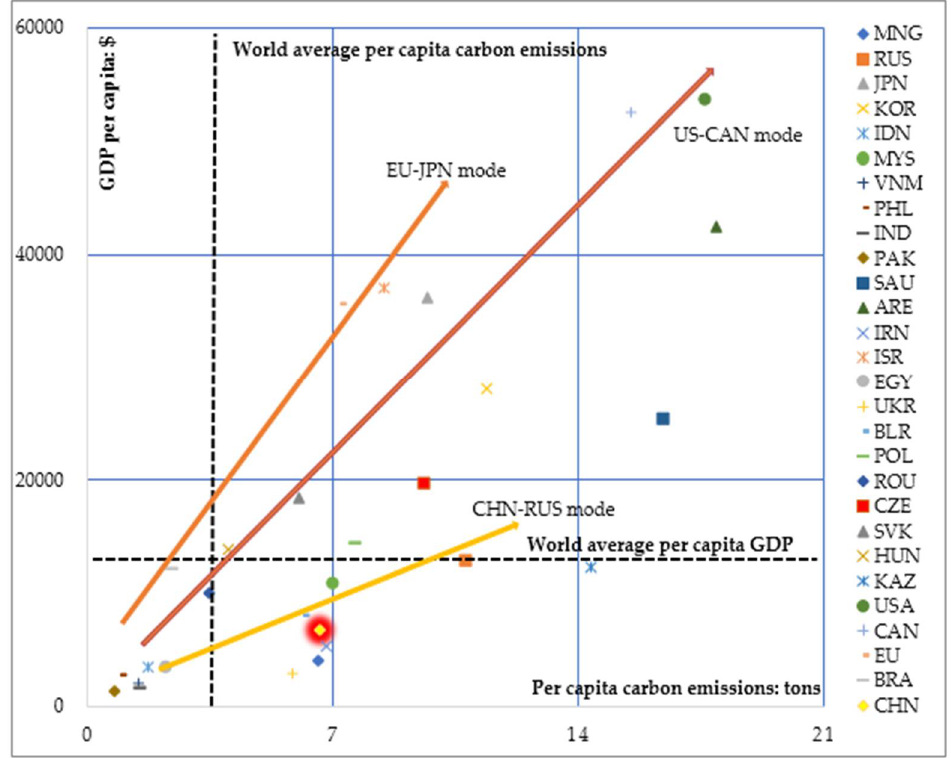
Figure 4. Per capita GDP and per capita carbon emissions in 27 major countries in 2013.